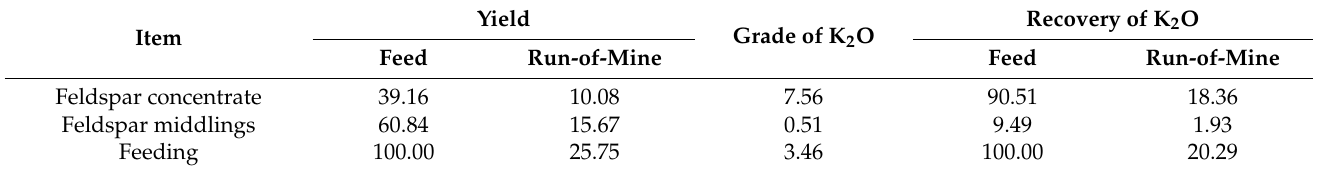
Table 10. Results of feldspar recovery and quartz purification (mass fraction, %).